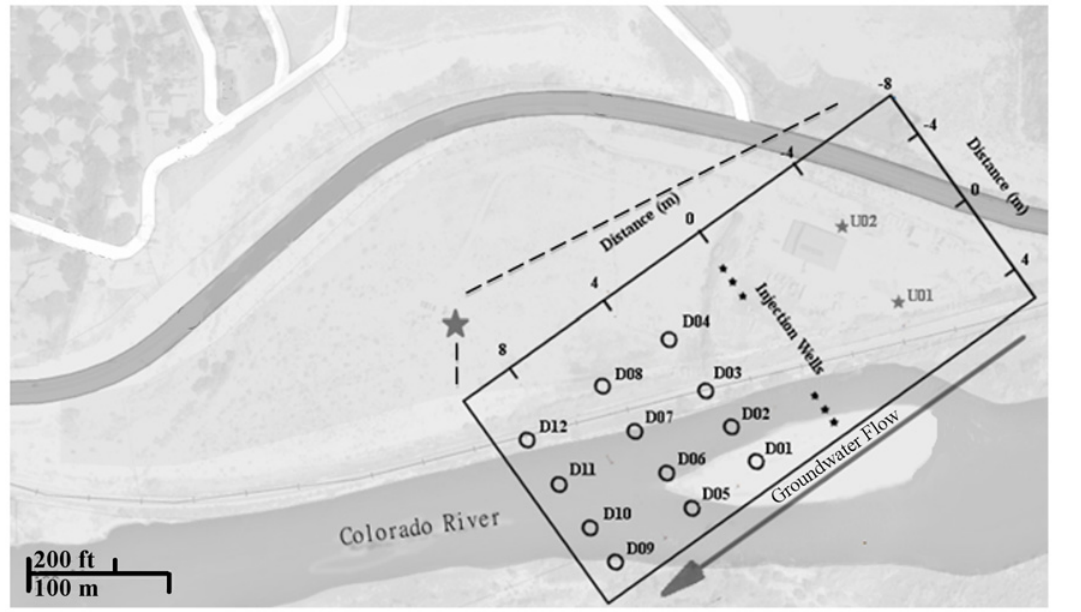
Fig 1. Map of the study area indicating sampling wells and groundwater